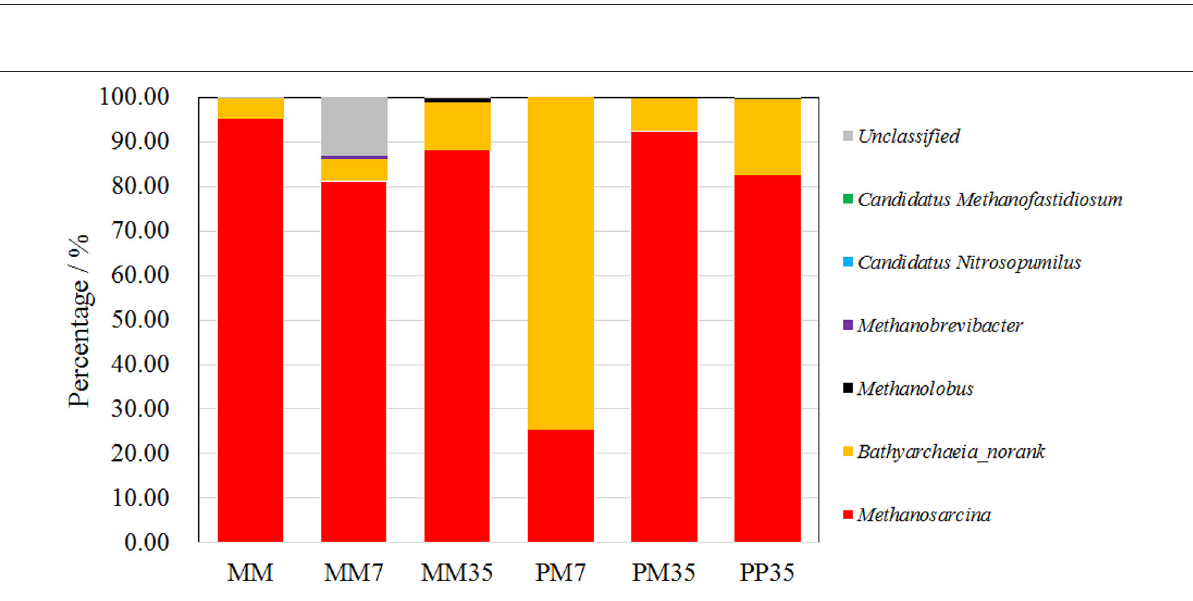
FIGURE 3 | The composition of archaeal community at genus level. PP represents the cultivations with PF pretreated coal and methanogenic microflora. PM represents the cultivations with raw coal and mixed culture of PF and methanogenic microflora. MM represent the methanogenic microflora after enrichment. The 7 and 35 respectively represent the incubation